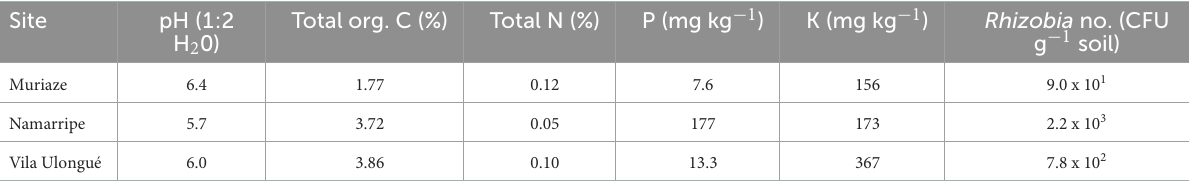
TABLE 1 Soil properties (0–30cm) and rhizobia population at the study